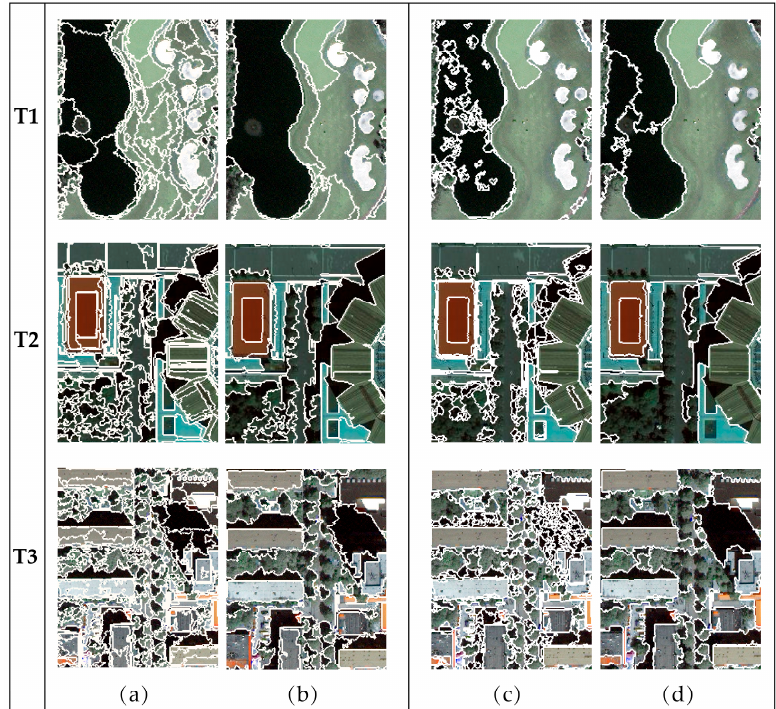
Figure 7. Subsets of multiscale segmentations produced by MRS and MSS for testing images T1, T2 and T3: ( a , b ) the results using the MRS algorithm at scale 2 and scale 19, respectively; and ( c , d ) the results using the MSS algorithm at scale 2 and scale 19, respectively. The segmentation boundaries are delineated by white lines.